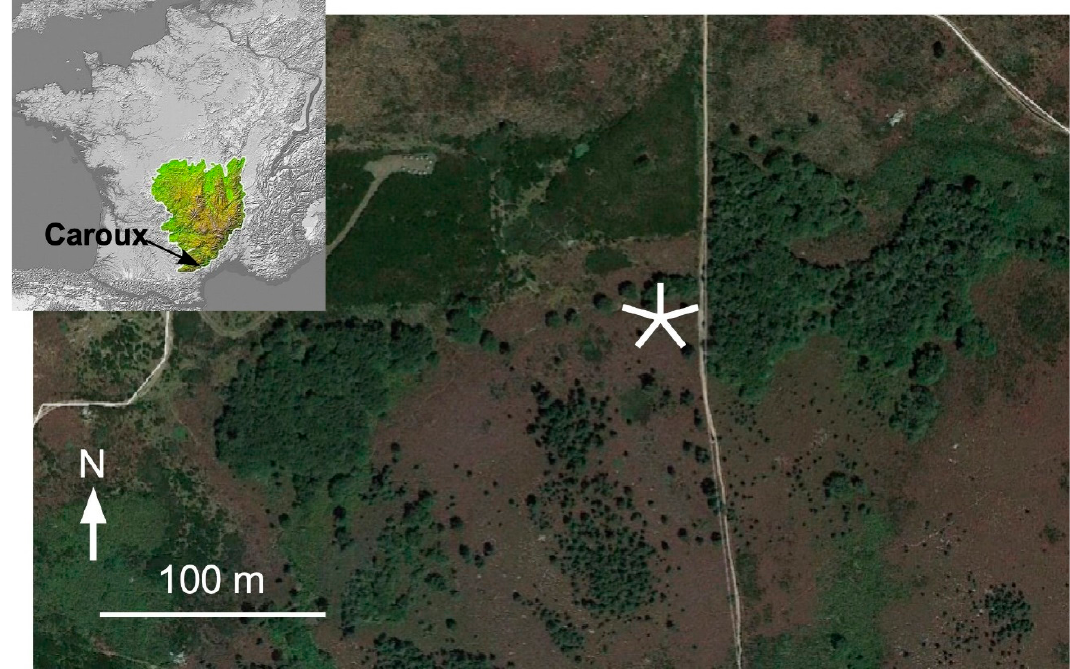
Figure 1. Aerial view of the studied site (GoogleEarth image, 2014); the exact location of the coring is indicated by the white asterisk. The inset shows the location of the Caroux plateau in the southwestern Massif Central (map from Wikimedia, used under CC BY-SA).